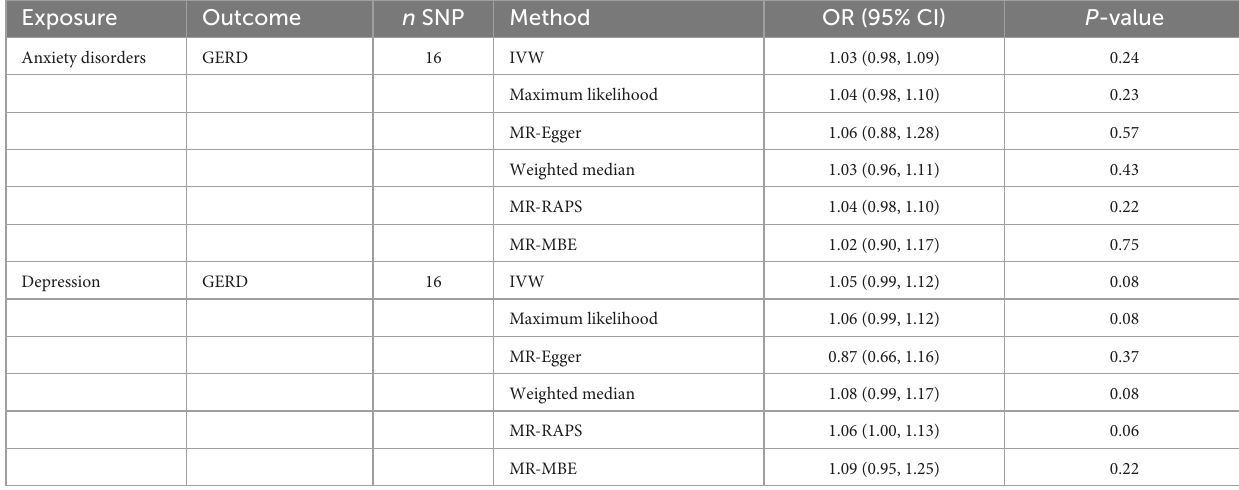
TABLE 9 Reverse MR results of the causal effect of anxiety disorders and depression on GERD.